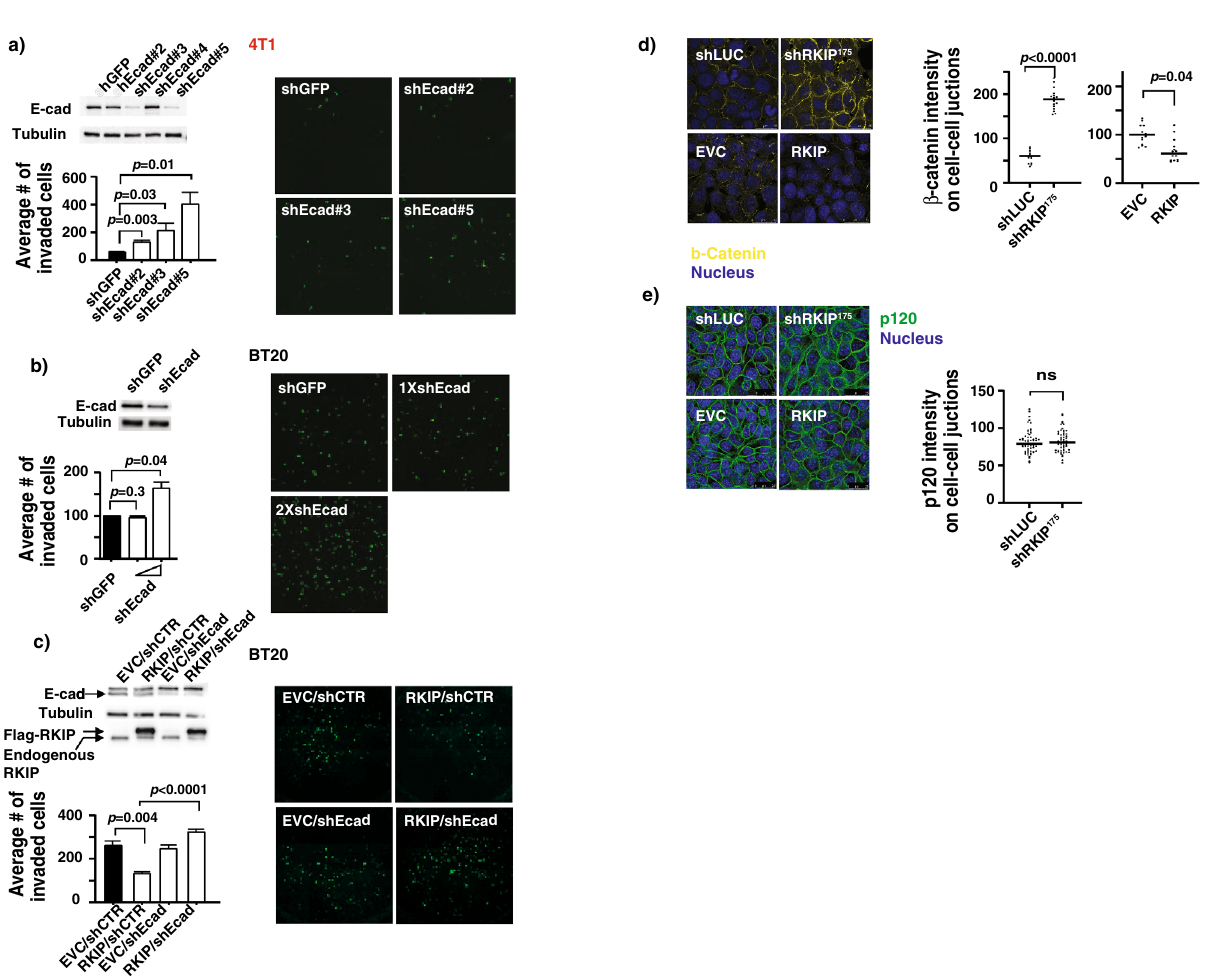
Figure 3. RKIP-mediated inhibition of cell invasion depends on the E-cadherin (E-cad) cell–cell junction localization. ( a ) (Top left panel) Representative western blots of lysates prepared from control knockdown (shGFP), or four different E-cad knockdowns (shEcad#2–5) 4T1 cells. (Bottom left panel) Representative results of invasion assays with same set of cells showing number of invaded cells through Matrigel in each indicated 4T1 cell lines (mean ± SE). (Right panel) Representative images of the stained invaded cells in indicated cell lines shown in the bottom left panel. ( b ) (Top left panel) Representative western blots of lysates prepared from control knockdown (shGFP), or E-cad knockdowns BT20 cells. (Bottom left panel) Representative results of invasion assays with shGFP control knockdown or titrated E-cad knockdown showing number of invaded cells through Matrigel in each indicated BT20 cell lines (mean ± SE). (Right panel) Representative images of the stained invaded cells in indicated cell lines shown in the bottom left panel. ( c ) (Top left panel) Representative western blots of lysates prepared from BT20 cells with different combinations of controls, E-cad knockdown (shEcad) and RKIP expression as indicated. (Bottom left panel) Representative results of invasion assays with same set of cells showing number of invaded cells through Matrigel in each indicated BT20 cell lines (mean ± SE). (Right panel) Representative images of the stained invaded cells in indicated cell lines shown at the bottom left panel. ( d ) (Left panel) Representative western blots of lysates prepared from BT20 cells with different combinations of controls, RKIP knockdown (shRKIP 175 ) and RhoAQL expression as indicated. (Left, bottom) Representative images of immunofluorescent staining with β-Catenin Ab and DRAQ5 (Nucleus) of BT20 cells with control knockdown (shLUC), RKIP knockdown (shRKIP), empty vector control (EVC) or RKIP expression. (right panel) β-Catenin intensity quantification on cell–cell junctions of immunofluorescent images shown in the left panel using MetaMorph analysis software. Representative images of immunofluorescent staining with p120 Ab and DRAQ5 (Nucleus) of BT20 cells with control knockdown (shLUC), RKIP knockdown (shRKIP), empty vector control (EVC) or RKIP expression. (Right panel) p120 intensity quantification on cell–cell junctions of immunofluorescent images shown in the left panel using MetaMorph analysis software. Unpaired Student’s t-test (two-tailed) was used for all analyses with p < 0.05 considered significant. ns not